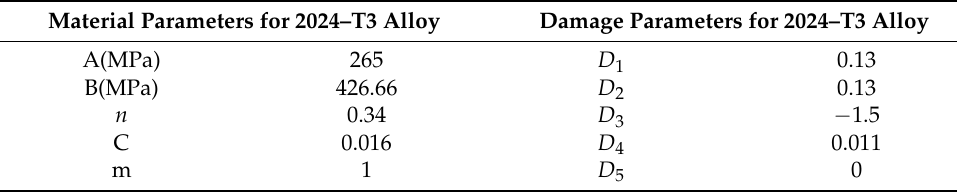
Table 3. J.C. Parameters obtained for AL 2024 T3 alloy.